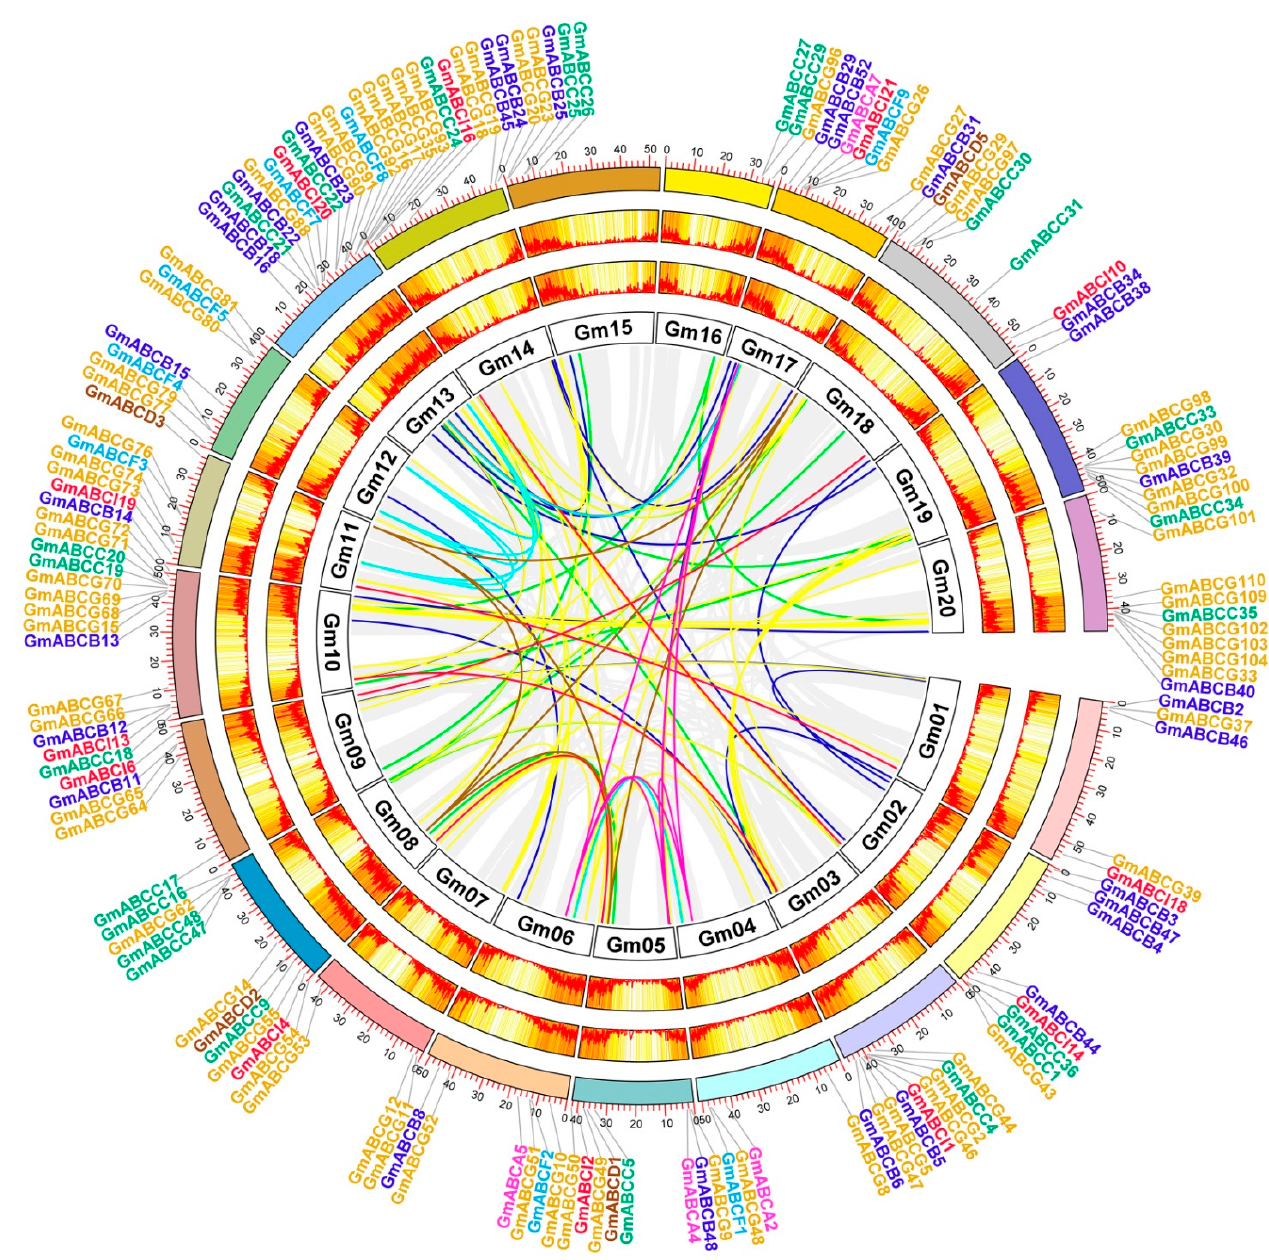
Figure 5. Schematic of the interchromosomal relationships of soybean ABC genes. Gray lines indicate all syntenic blocks in the soybean genome, and the colored lines indicate duplicated ABC gene pairs. The heatmaps represent the gene density. To detect which selection type promoted GmABC transporter evolution, we calculated Ka/Ks values for GmABC genes in duplicated genes. In addition to the GmABCA2 / GmABCA5 , GmABCA4 / GmABCA5 , and GmABCA5 / GmABCA7 gene pairs, the Ka/Ks ratios of